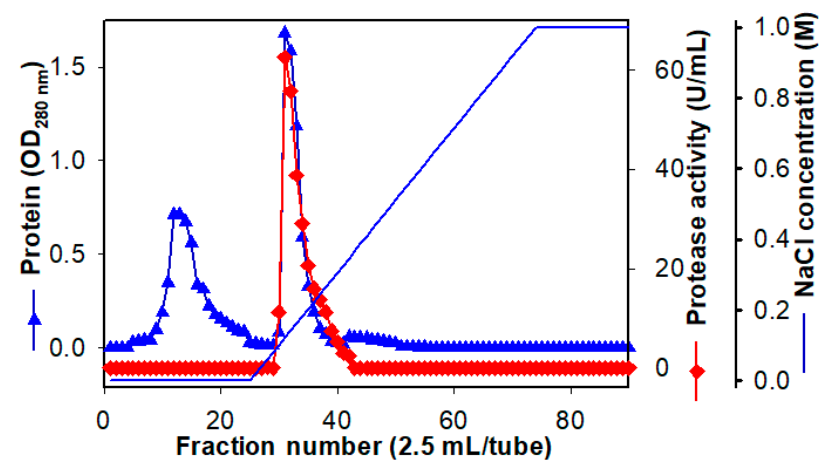
Figure 3. A typical chromatogram of Macro-prep High S column of Paenibacillus sp. TKU047 protease. The purification of Paenibacillus sp. TKU047 was also analyzed by sodium dodecyl sulfate-